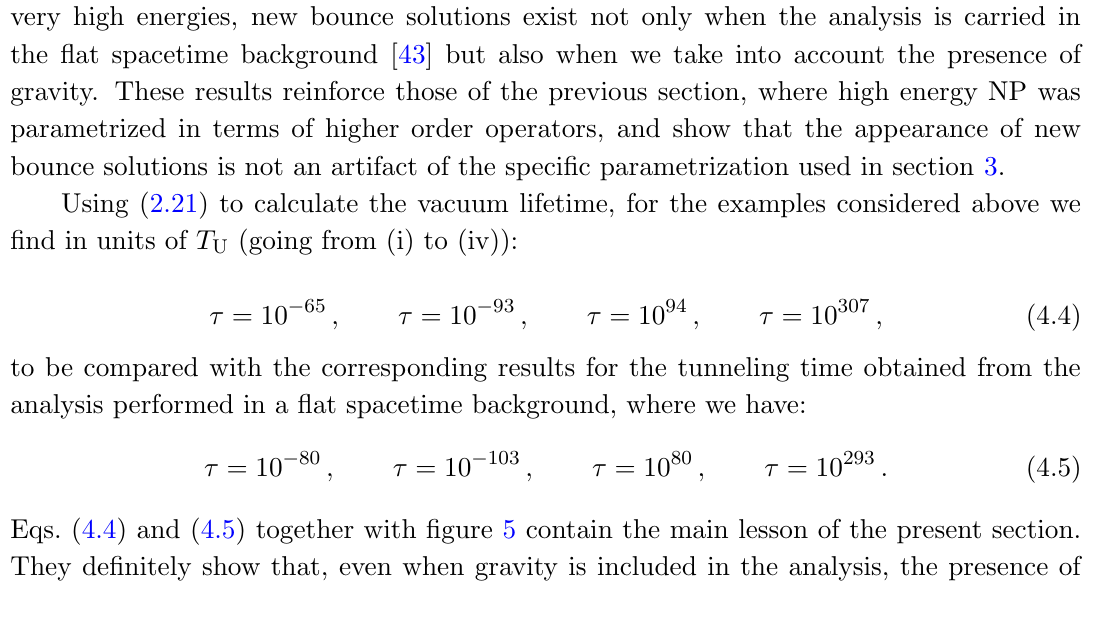
Figure 5 . Left panel : pro(cid:12)le of the bounce solutions ’ ( x ) for the potential (4.3) relative to the four cases considered in the text: M S = 2 : 5 (cid:2) 10 (cid:0) 1 , M f = 3 (cid:2) 10 (cid:0) 4 , g S = 0 : 96, g 2 M S = 2 : 0 (cid:2) 10 (cid:0) 1 , M f = 10 (cid:0) 4 , g S = 0 : 9, g 2 g 2 = 0 : 4 (green); M S = 1 : 5 (cid:2) 10 (cid:0) 1 , M f = 5 (cid:2) 10 (cid:0) 3 , g S = 0 : 92, g 2 f corresponding di(cid:11)erence between the curvature radius and its asymptotic value, a ( x ) (cid:0) x , for the same parameters as in the left